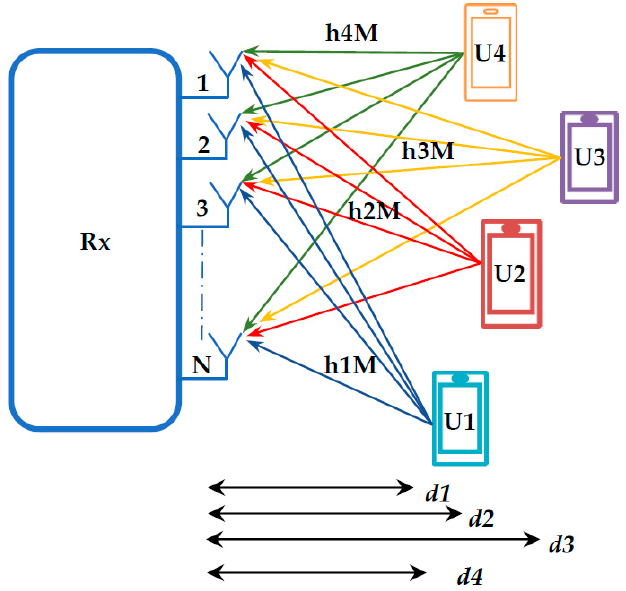
Figure 2. Illustrates the wireless network consisting of 4 users 64 × 64 MIMO-UL-NOMA (power